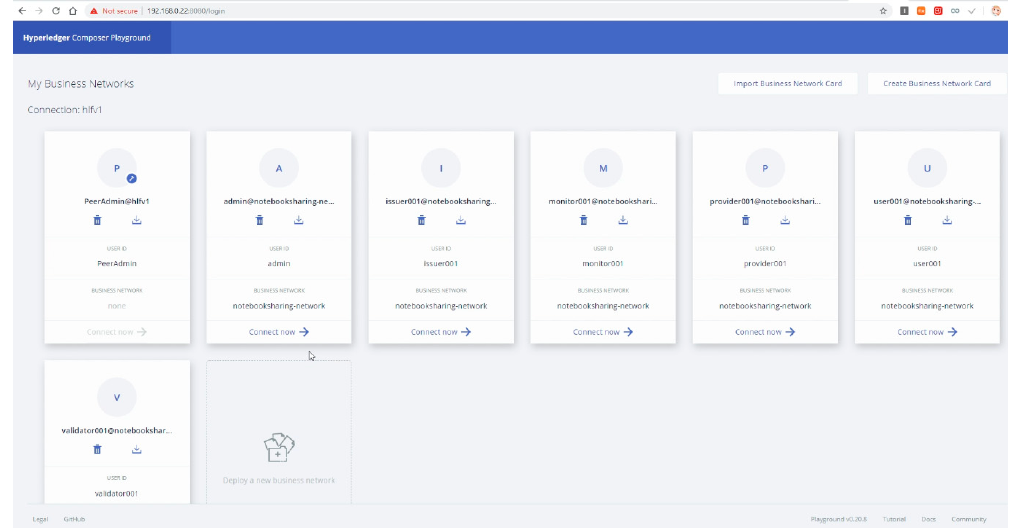
Figure 13. Sample participant certificate issued by Fabric-CA using X.509.